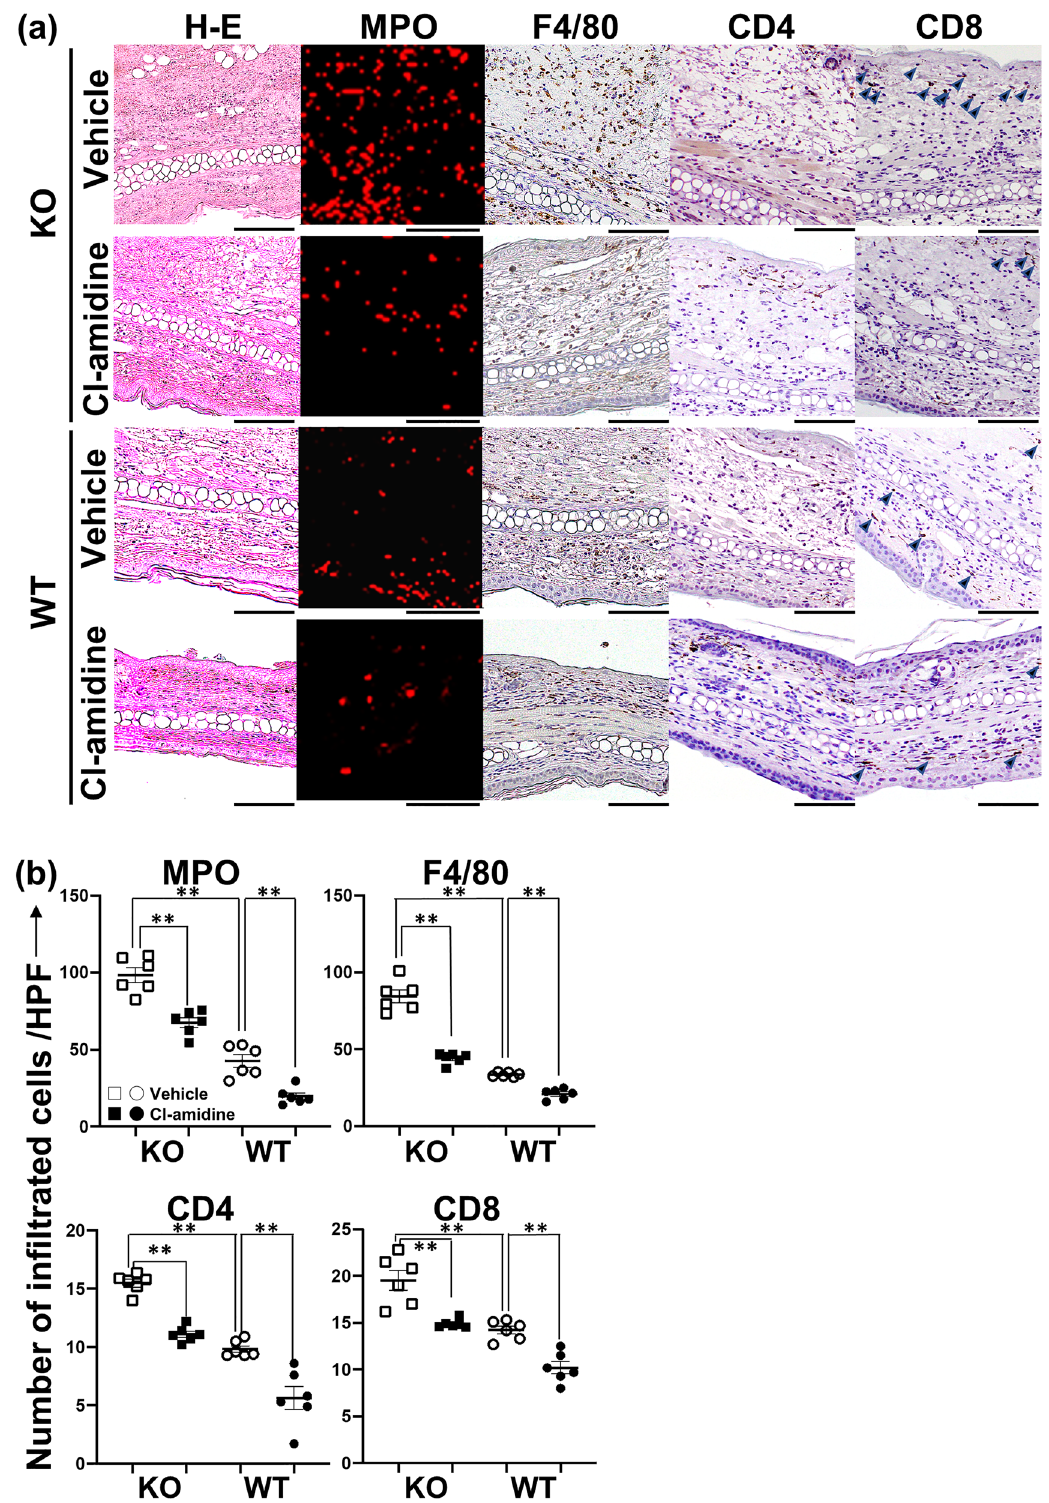
Figure 2. Effect of Cl-amidine on inflammatory cell infiltration in the ear skin during the contact hypersensitivity response in wild-type mice (WT) and Il36rn −/− mice (KO). ( a ) Representative histological images of ear skin from KO and WT treated with Cl-amidine (10 mg/kg/day) or the same quantity of vehicle 48 h after the DNFB challenge (hematoxylin and eosin (H&E) staining, myeloperoxidase (MPO) staining, F4/80 staining, CD4 staining, and CD8 staining; all scale bars = 100 μm). The infiltrated neutrophils tested positive for MPO (red). The infiltrated macrophages were stained for F4/80. CD8+-positive T cells were indicated by arrow heads. ( b ) The number of MPO + neutrophils (MPO), F4/80 + macrophages (F4/80), CD4 + T cells (CD4), and CD8 + T cells (CD8) per field (0.16 mm 2 ) was counted under a microscope. All values represent the mean ± SEM obtained from six mice per group. (** p <